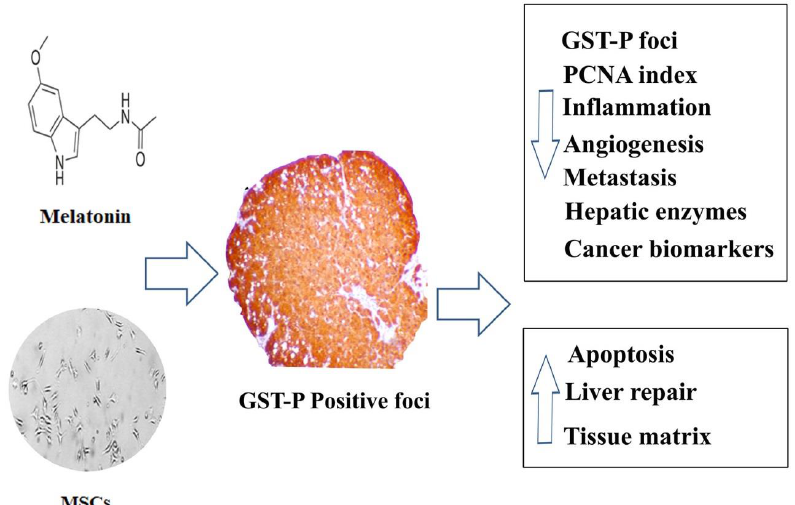
Figure 3. E ff ects of the combined use of melatonin and MSCs on hepatocellular carcinoma (HCC); ((GSTPS: glutathione S-transferases), (PCNA: proliferating cell nuclear antigen))